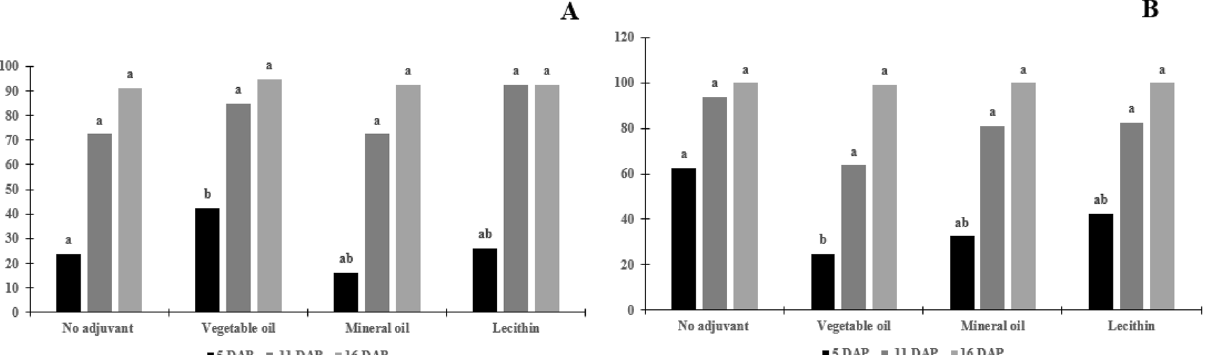
Figure 4. Percentage of control of Lantana camara L. plants after herbicide solution spraying. ( A ) Aminopyralid + fluroxypyr at 155.3 L of active ingredient ha −1 . ( B ) Aminopyralid + fluroxypyr at 360.6 L of active ingredient ha −1 . Equal letters within the evaluation days, the adjuvants do not differ from each other by the Tukey test (p > 0.05).